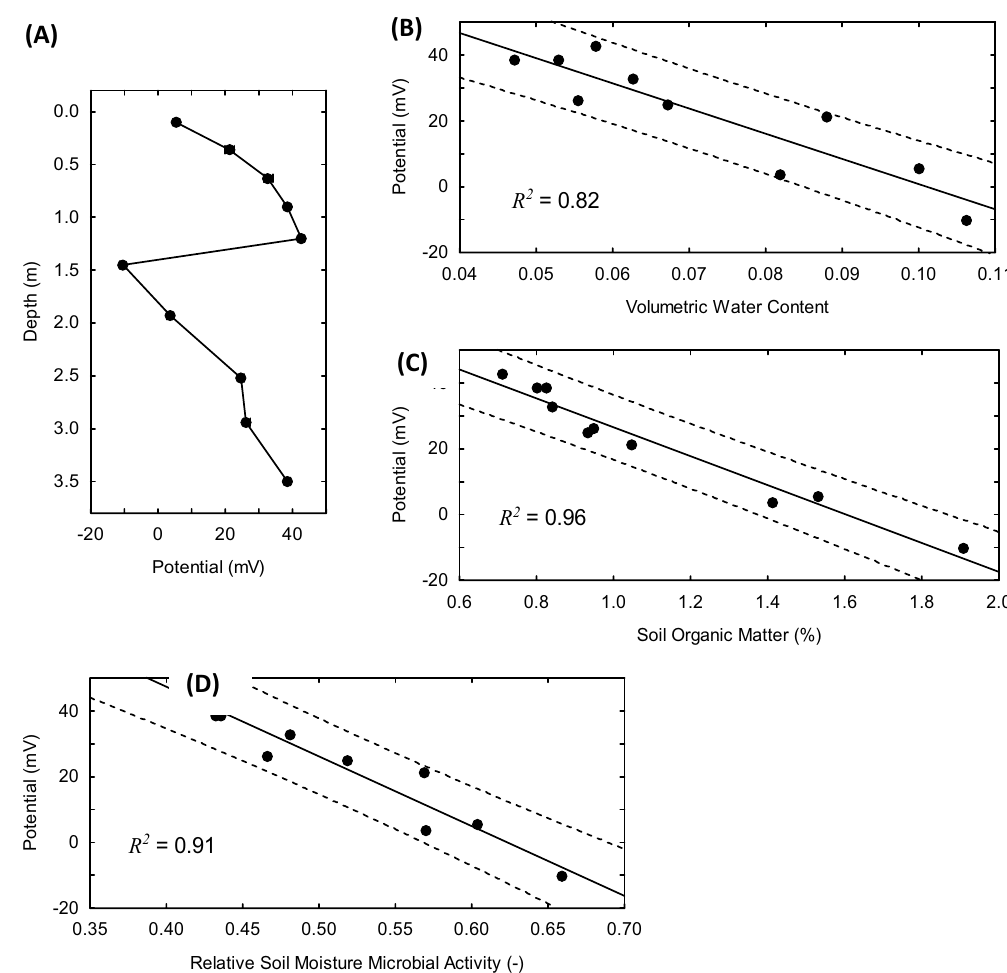
Figure 2. ( A ) Soil depth profile of mean self-potential values from 1200 s time series recorded at a sampling frequency of 1.0 Hz; the dot diameter indicating the mean values is larger than + 2 σ of the time series. Self- potential response as a function of ( B ) volumetric water content, ( C ) soil organic matter content, and ( D ) soil moisture microbial activity; solid lines represent the best fits obtained for the corresponding linear regression equations. Dashed lines are prediction intervals at p values that represent the proportion of variance accounted for by the regression ( R 2